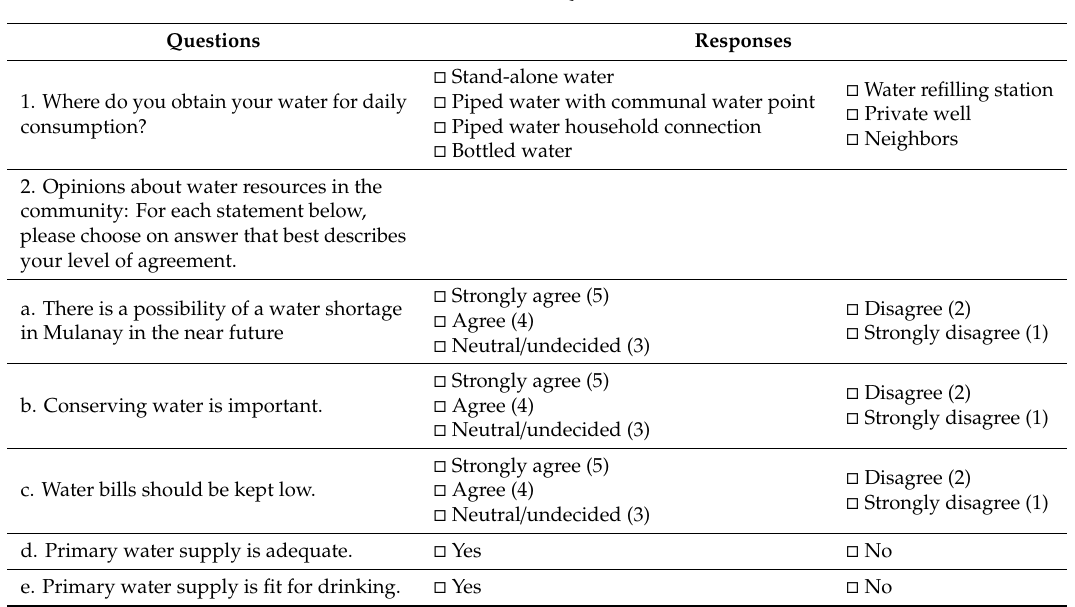
Table A2. General Questionnaire.